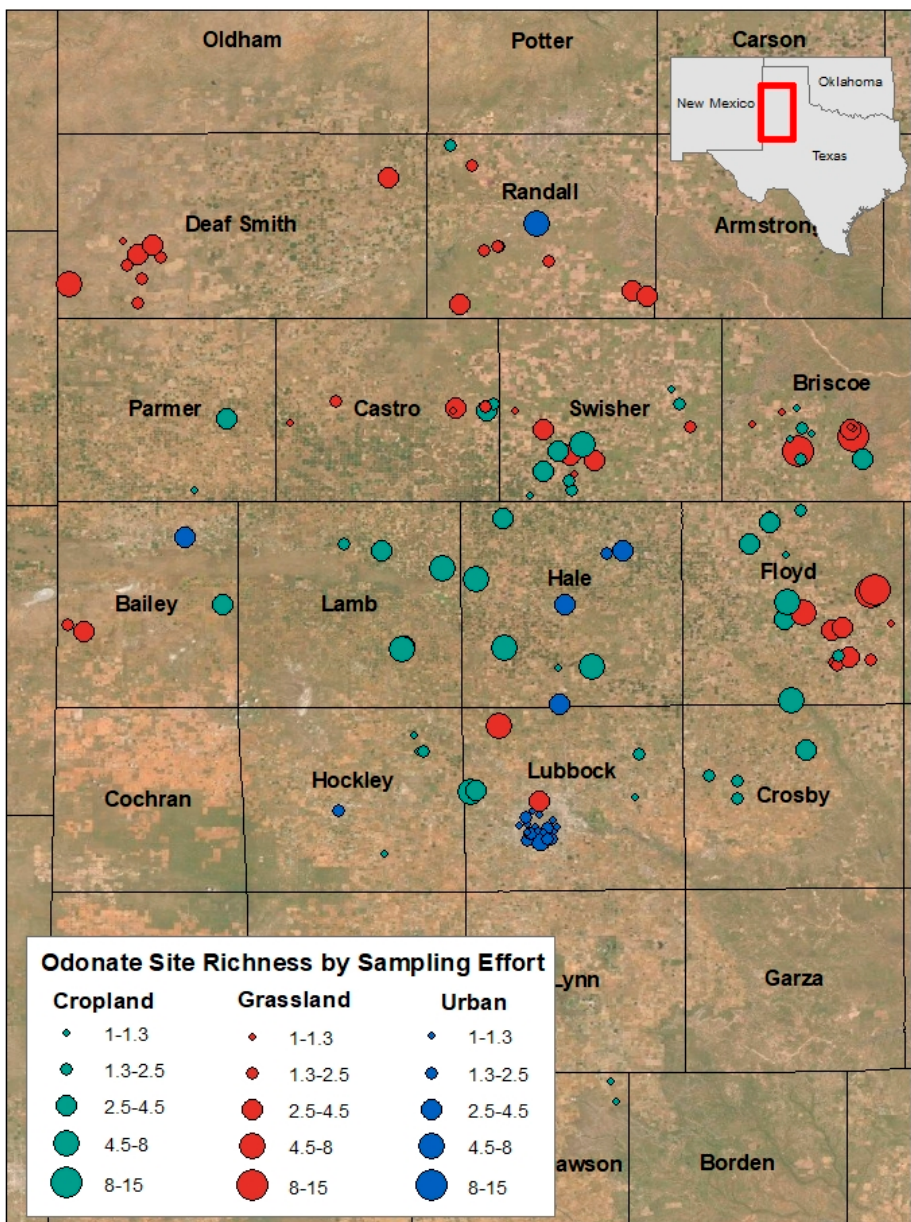
Figure 4. Map of field study sites by surrounding land use/land cover type, with symbols sized commensurately to odonate species richness, scaled by sampling effort (number of sampling visits) across the Texas panhandle (United States), 2003–2020; categories were based on natural breaks in the data. Basemap layer from Esri (Redlands, CA, United States).